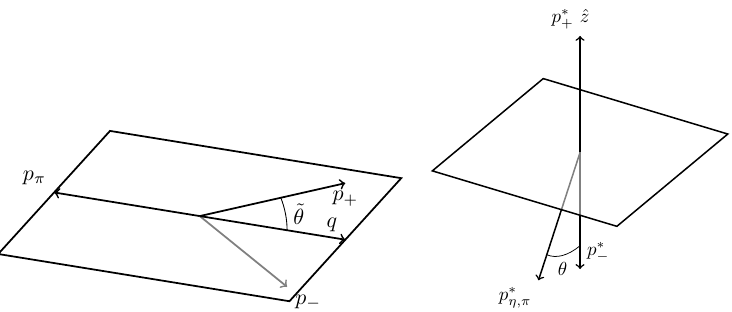
Figure 1 . Left: the coordinates in the η rest frame. Right: the coordinates in the dilepton frame. Note that the longitudinal ( ˆ z ) axis is chosen along the µ + direction and that θ 6 = ˜ θ . Only ~p ± sin ˜ θ = ~p ∗ sin θ is preserved in the ±